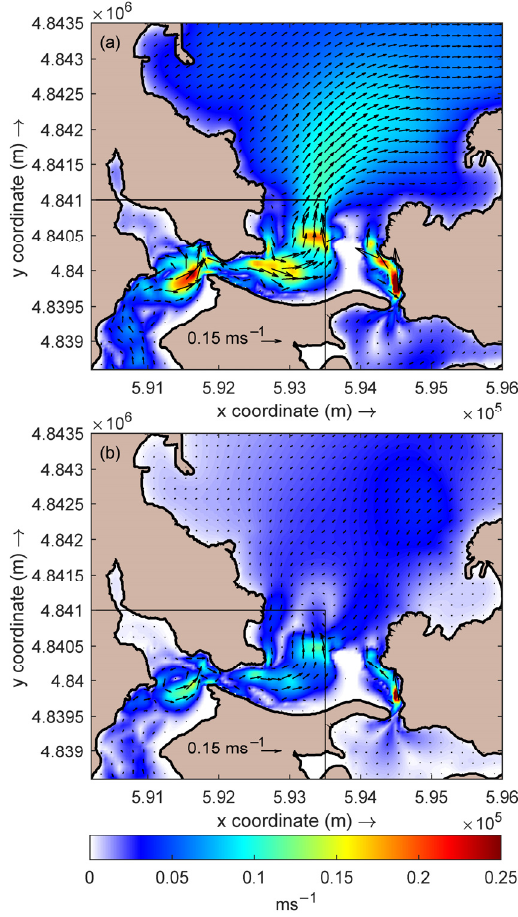
Figure 8. Residual flow pattern in Ria de Ortigueira under case study CS3 conditions. ( a ) Surface layer; ( b ) bottom layer.